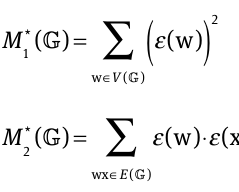
[r] for r = 1 and r = 1